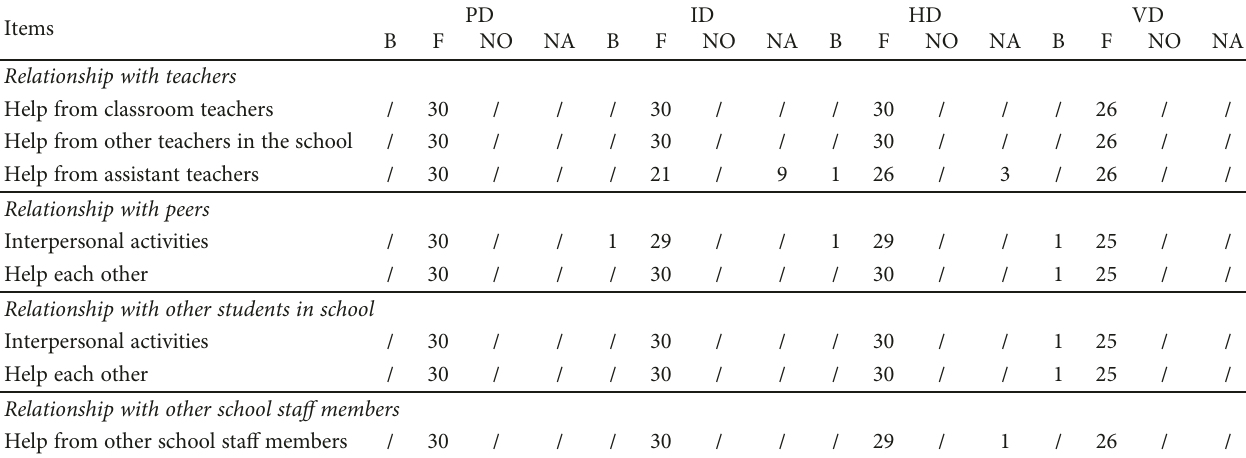
Table 9: Facilitators and barriers of the social